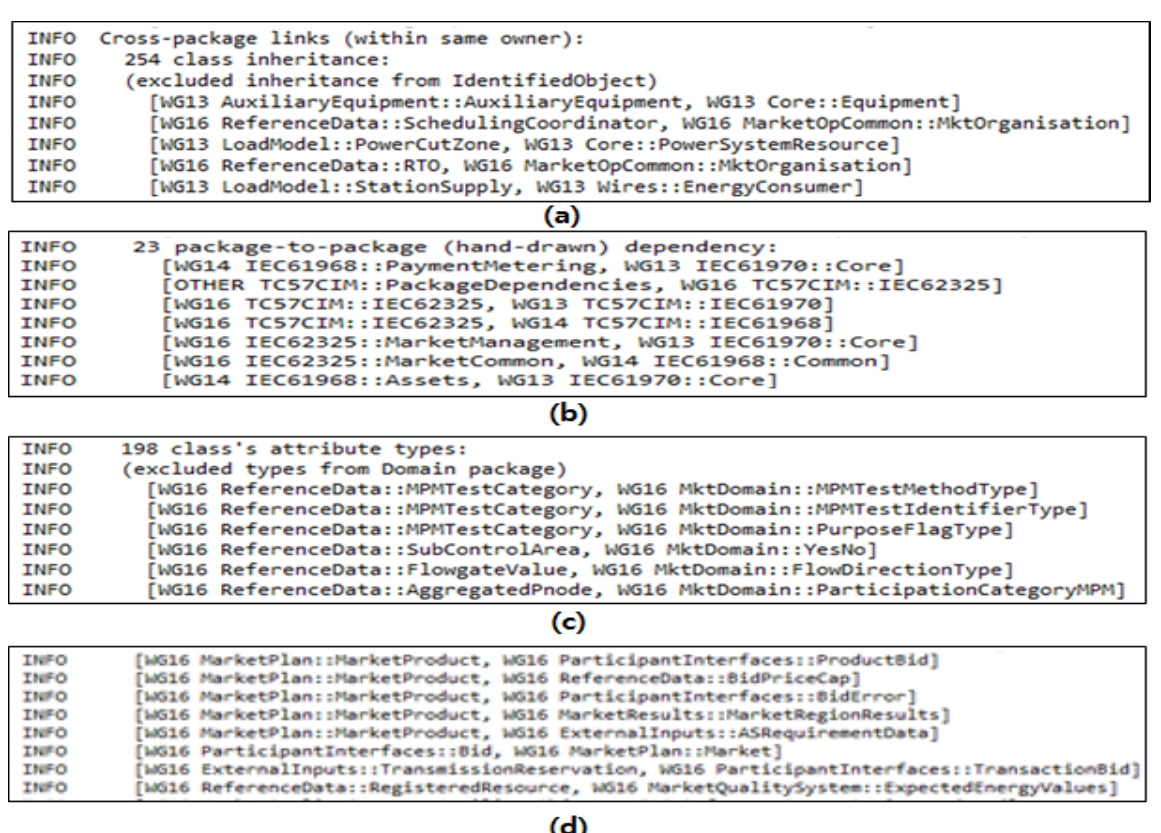
Figure 10. Simulation results of distributed microgrid information distributed model ( a ) Cross pack-